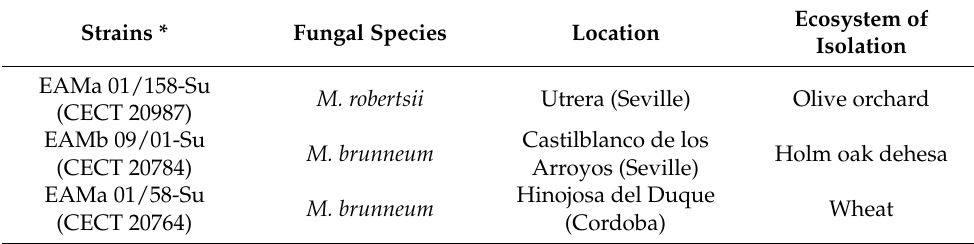
Table 1. Strains used in the study of microsclerotia production. Strains * Fungal Species Location